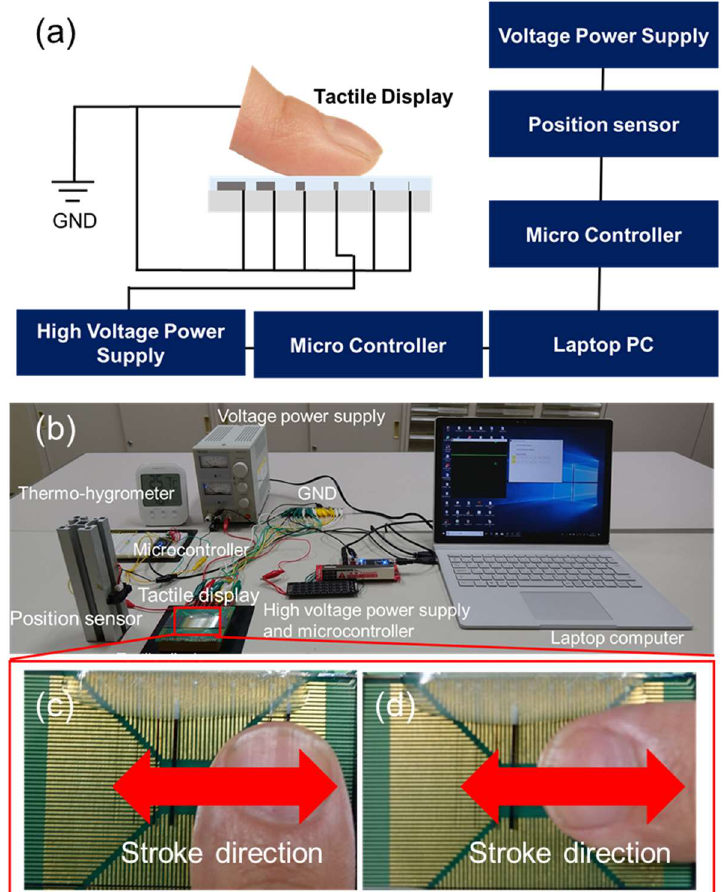
Figure 5. ( a ) Schematic illustration of the experimental setup. The selected electrode is connected to a high voltage power supply and other electrodes are grounded. In this case, the fourth electrode from the left is connected to the high voltage and the other electrodes are connected to the ground. ( b ) Actual photograph of the experimental setup. ( c – d ) Images of the stroke directions.